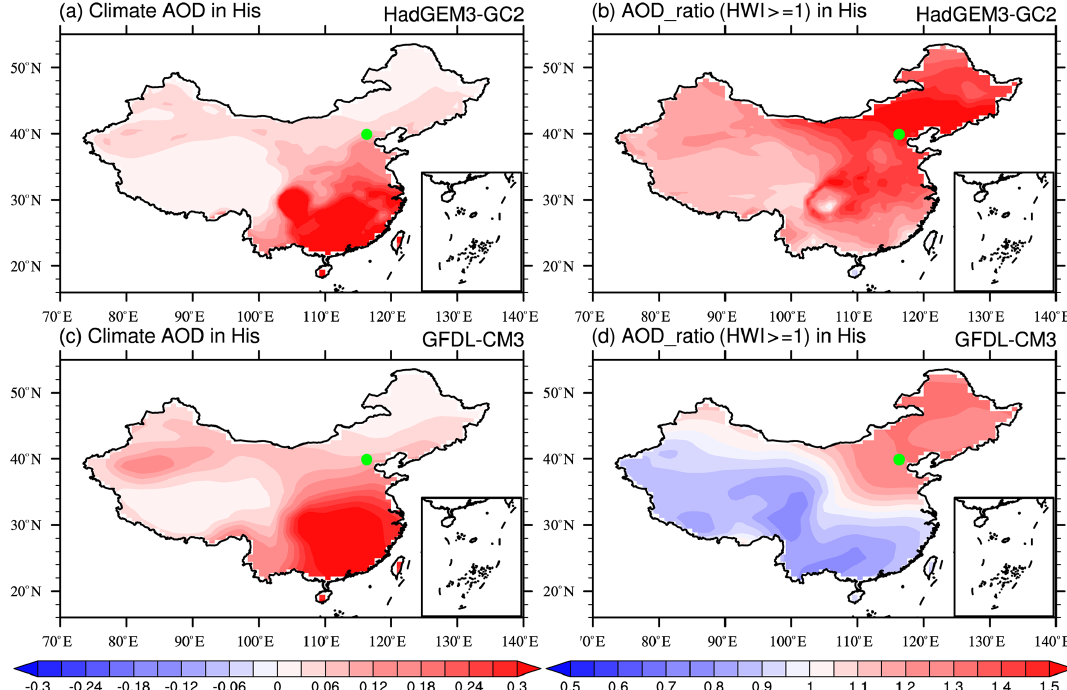
Figure 9. Winter mean (a, c) AOD at 550nm in (a) HadGEM3-GC2 and (c) GFDL-CM3 averaged over 1984–2013. Panels (b, d) are the same as (a, c) but for the mean AOD_ratio in the winter months with HWI ≥ 1 (hereafter AOD_ratio(HWI ≥ 1)) in His. Blue and red shadings in (b) and (d) are decreased and elevated AOD relative to the climate winter mean of His,